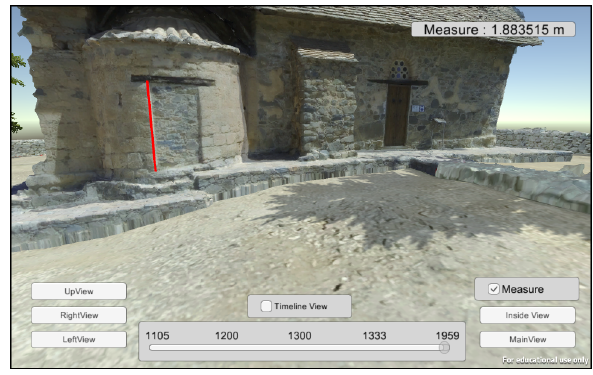
Figure 7: Measuring tools in 3D virtual